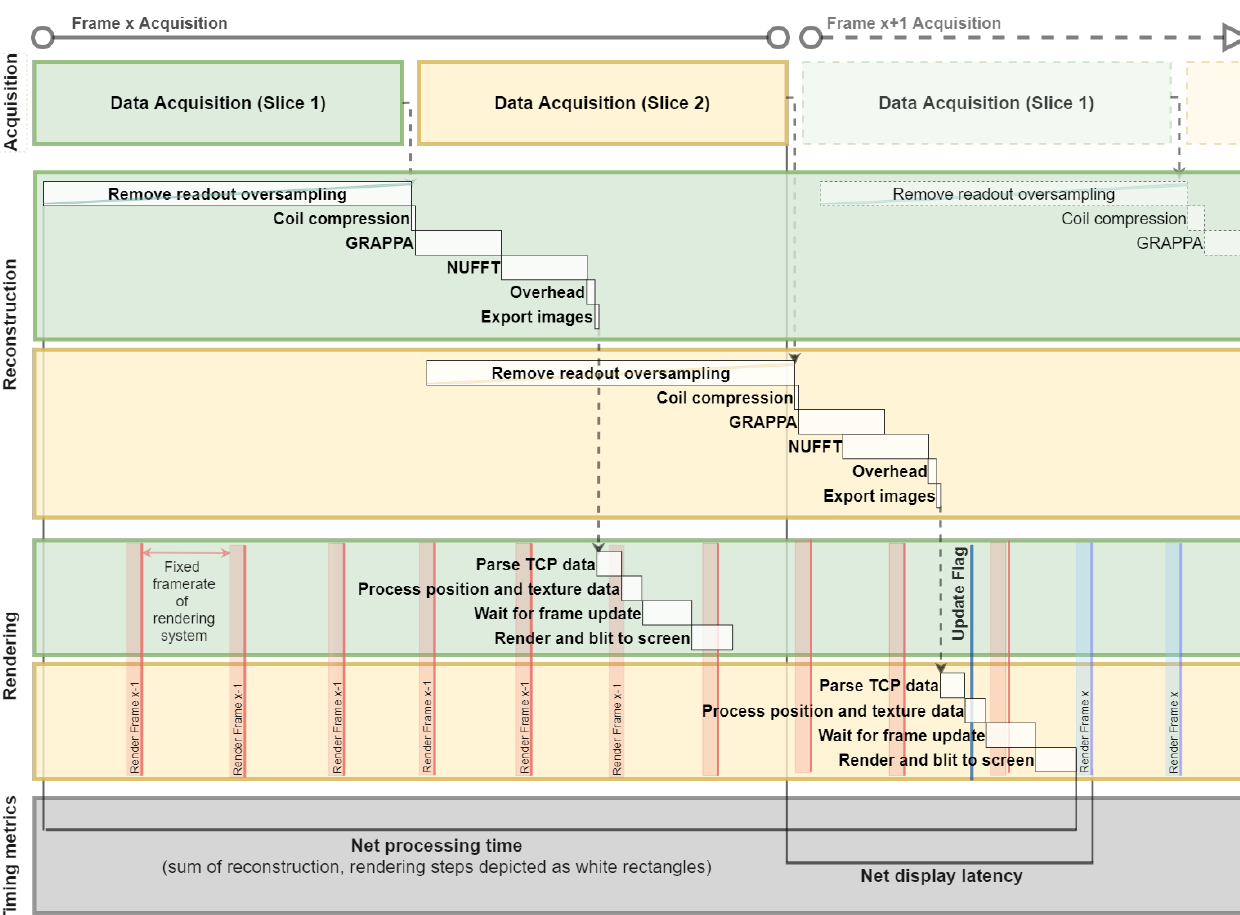
Figure 3. Schematic showing the relative timings of the acquisition, reconstruction, and rendering processes and their sub-steps for a two-slice planar scan. Each frame comprises two slices that are acquired sequentially. The removal of readout oversampling is performed on each line of data as it is acquired, as indicated by the diagonal bar across the sub-step rectangle. Data for the slice are buffered, followed by coil compression, GRAPPA, the NUFFT, and export of the images to the rendering system. The rendering processing includes receiving the image data over the TCP socket, parsing the data, and processing the data. Once all slices per frame are processed, as detected by an update flag, the images are rendered to the user on the next headset frame update. The net display latency is considered to be the time between when all of the data for one frame have been acquired and when that frame is displayed to the user. Note that all components of the system may be active at once, operating on different slices and/or frames of data